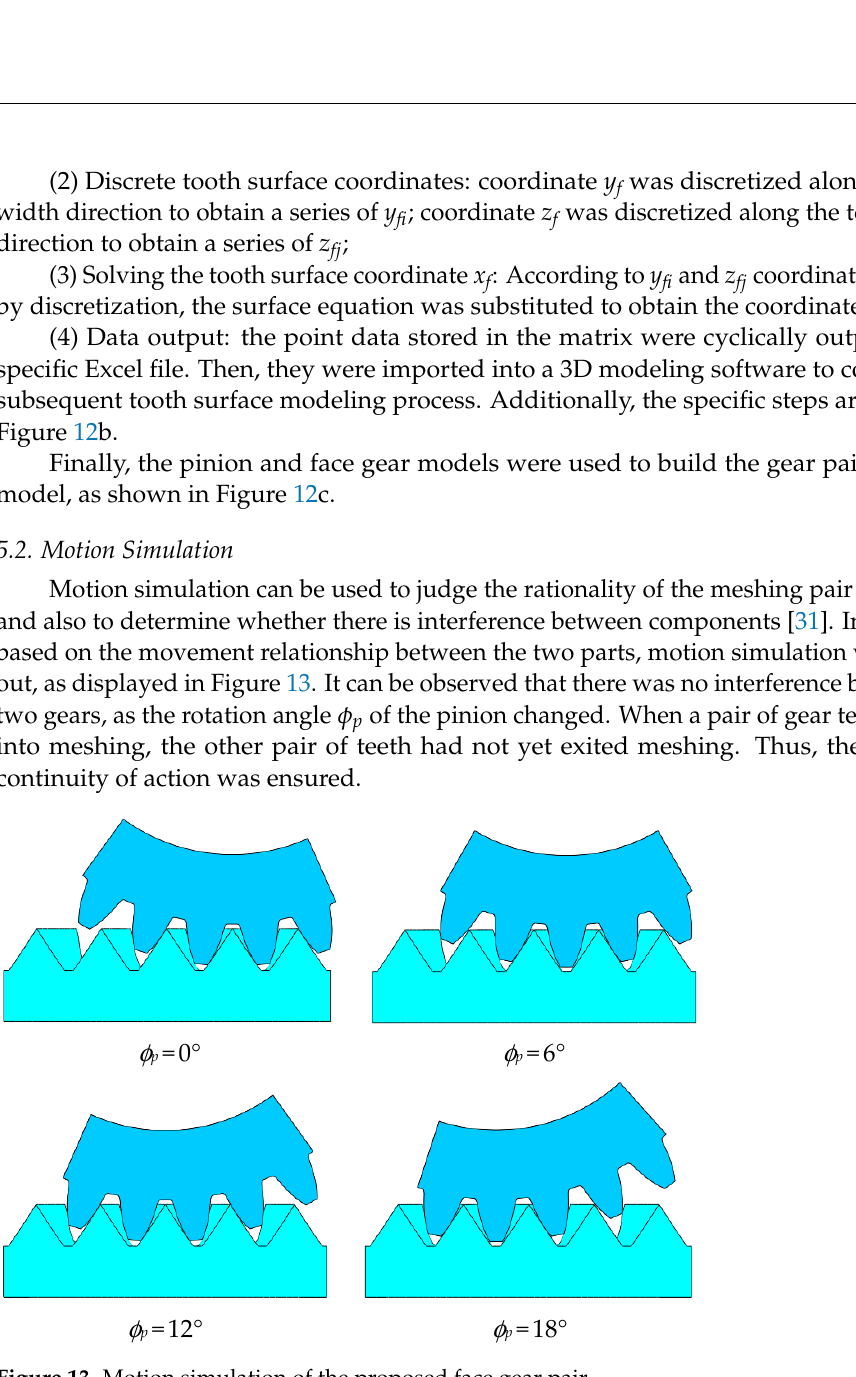
Figure 13. Motion simulation of the proposed face gear